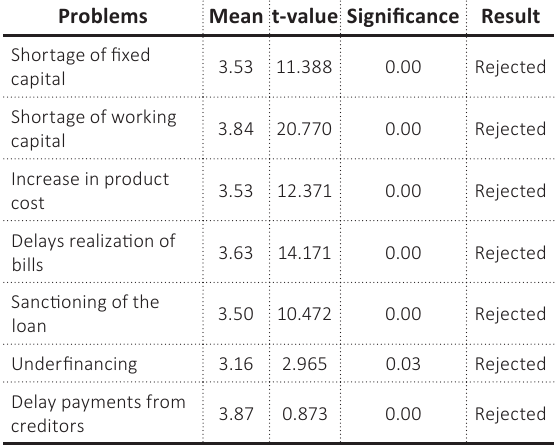
Table 4. Financial challenges